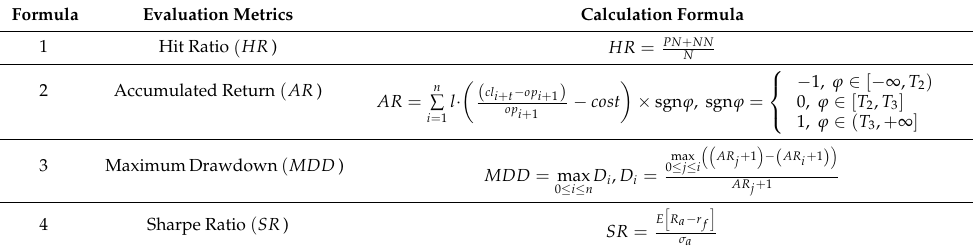
Table 4. Calculation formula of the four evaluation